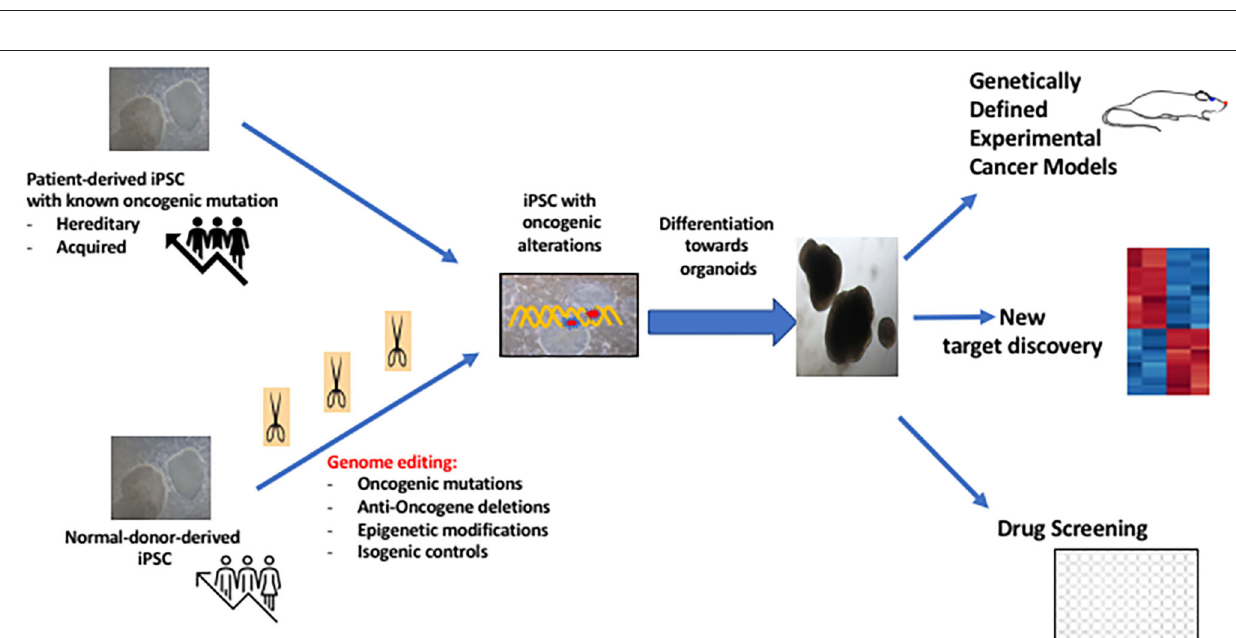
FIGURE 1 | iPSC-derived organoids and their potential use in Regenerative Medicine.